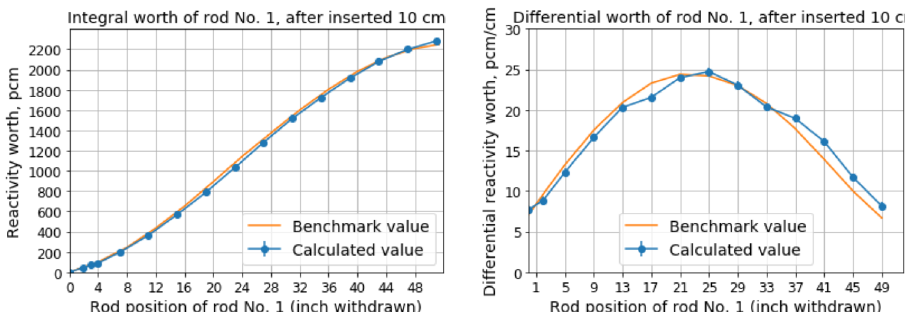
Figure 8. Integral Worth (Left) and Differential Worth (Right) of Rod No. 1 after Inserting All Control Rods 10 cm at the Beginning Positions.